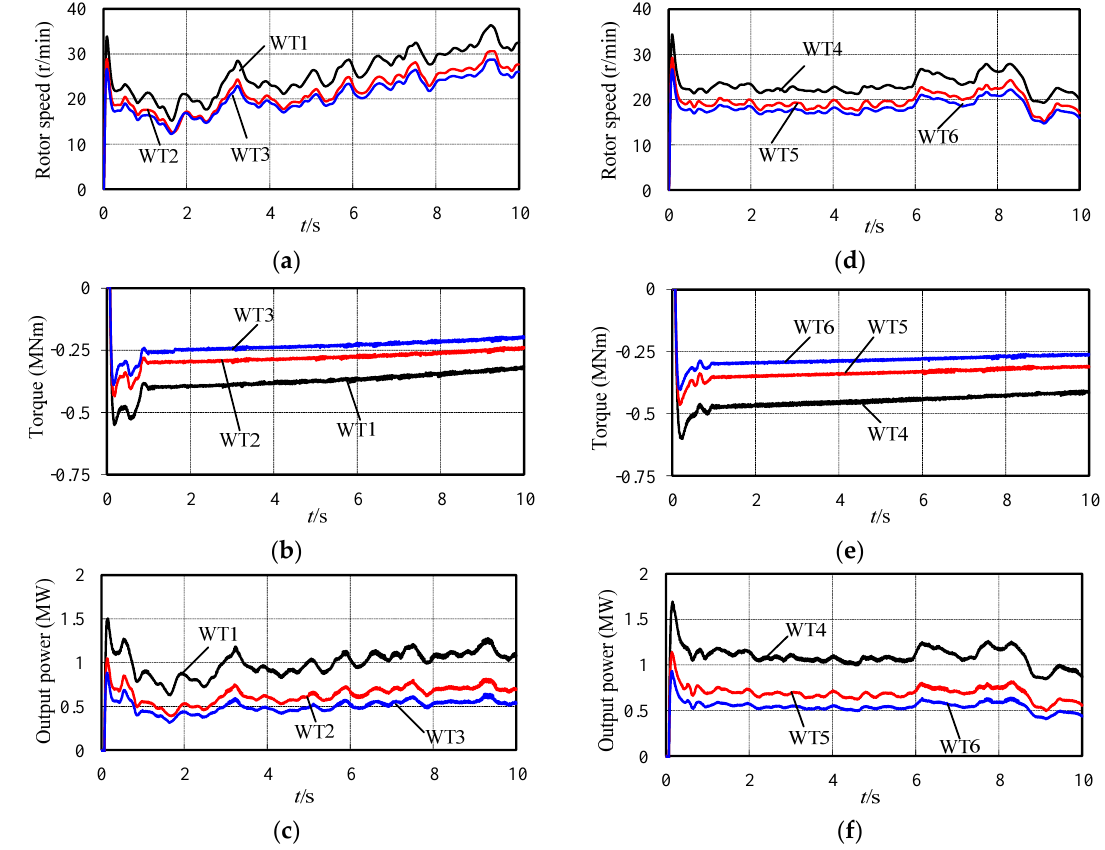
Figure 11. Time histories of the PWTs in the wind farm under the power smoothing operation mode. ( a ) Rotor speed of PWTs (1–3). ( b ) Torque of PWTs (1–3). ( c ) Output power of PWTs (1–3). ( d ) Rotor speed of PWTs (4–6). ( e ) Torque of PWTs (4–6). ( f ) Output power of PWTs (4–6).